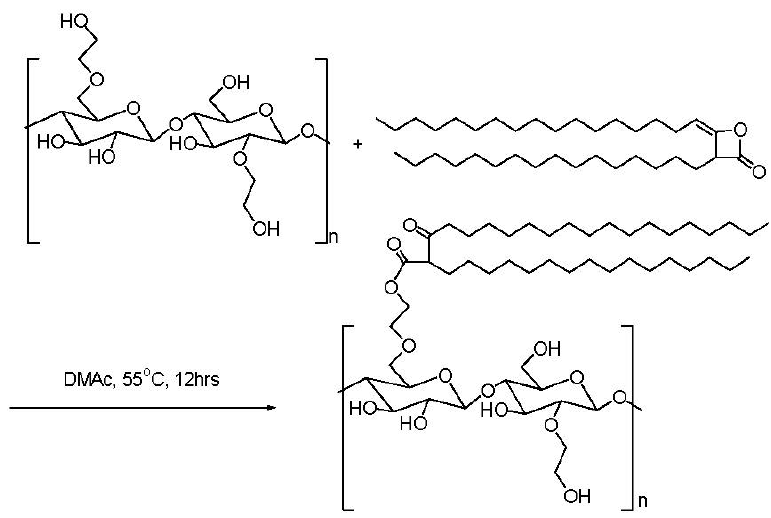
Figure 7. Lipase-catalyzed reaction of alkyl ketene dimers (AKD) with